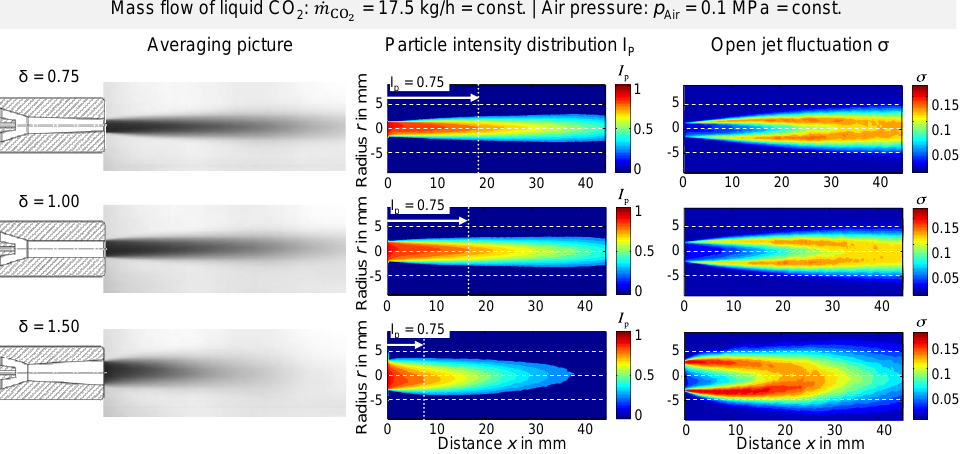
Figure 5. Influence of the nozzle aperture ratio on open jet intensity and open jet fluctuation.